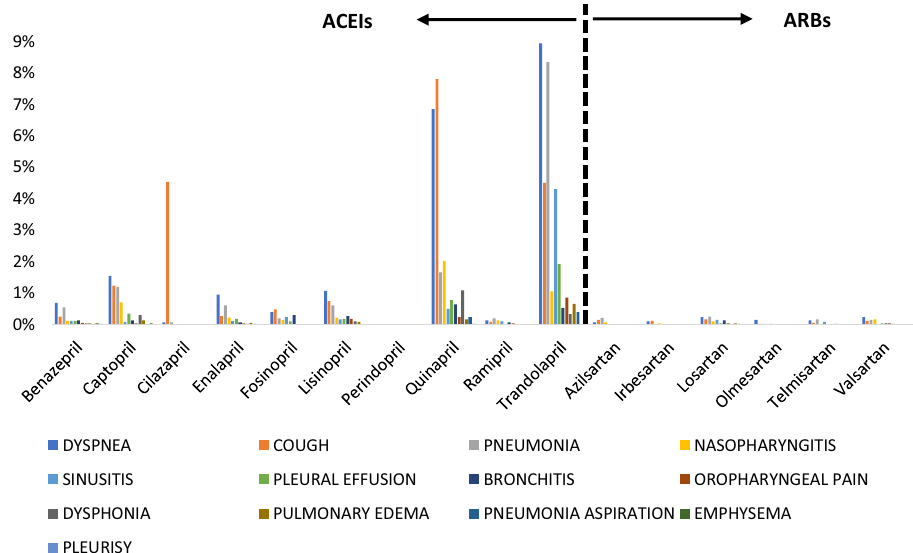
Figure 1. Percentage of the total number for a specific pulmonary ADE divided by total ADEs (n = 4582) from the first quarter of 2004 to the last quarter of 2019 reported for ACEIs and ARBs in patients with hypertension.